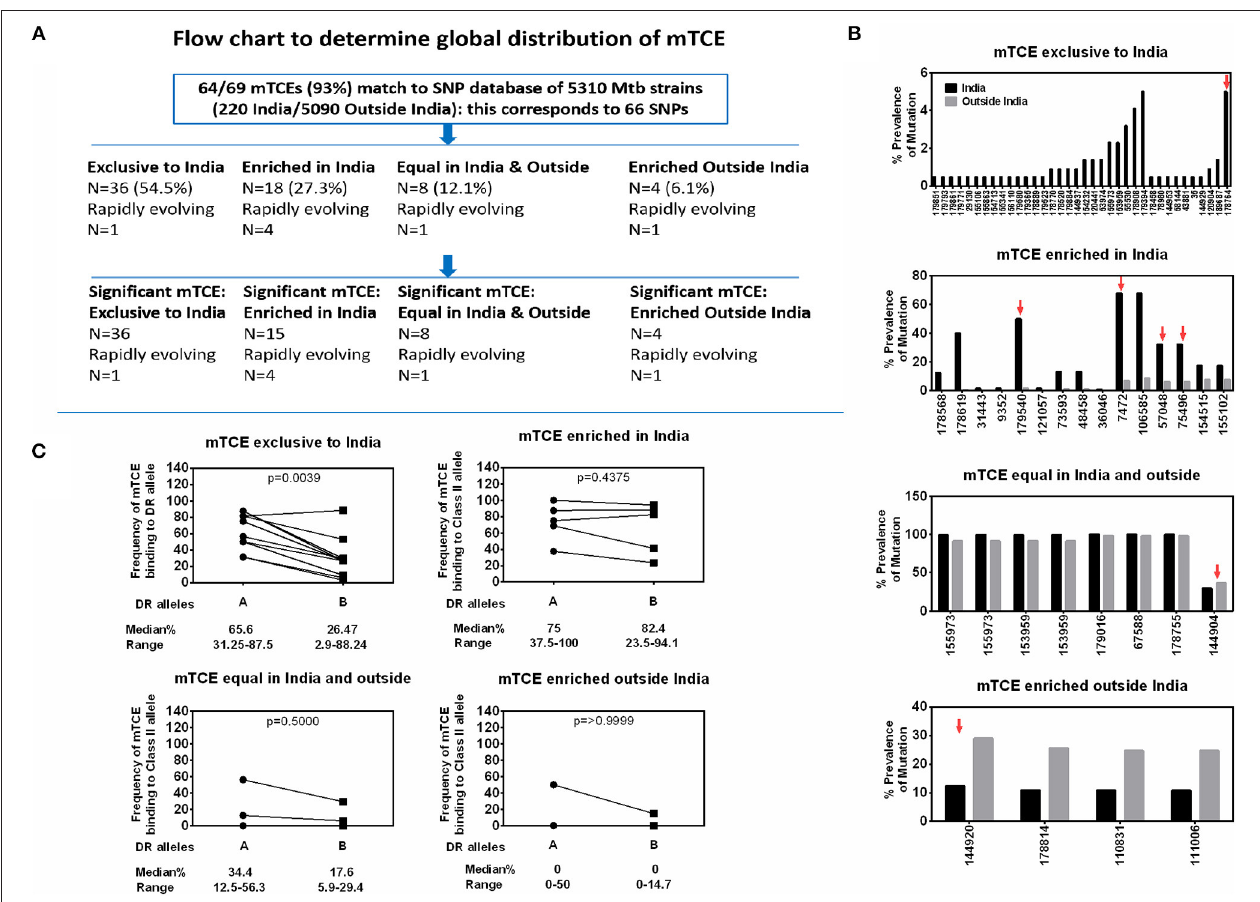
FIGURE 6 | Global distribution of 64 mTCEs and relationship to HLA-DR binding. (A) Flow chart shows the number of mTCEs identified in 79 Mtb strains from India, and their frequency in the context of non-synonymous SNPs (nSNPs) identified in 5,310 globally distributed Mtb strains ( 18, 60). After excluding mTCEs from repetitive regions ( n = 69/138), the remaining 69/138 mTCEs were mapped to nSNPs of 5,310 global Mtb strains, in which 64/69 mTCEs matched to corresponding 66 SNPs (some mTCEs have more than one mutation with each mutation corresponding to one SNP). These 66 SNPs in 64 mTCEs were classified into four groups based on their global geographic distribution in 5,310 Mtb strains as follows: mTCE exclusive to India; mTCE enriched in India; mTCE in equal proportion inside and outside India and mTCE enriched outside India. Of the 4 groups of mTCE identified, those that were significantly exclusive to ( N = 36) enriched ( N = 15) or enriched outside India ( N = 4) as determined by Fischer’s exact test adjusted for multiple comparison with a p -value cut-off of < 0.001 is shown. Only for one group: mTCE in equal proportion in both India and outside India ( N = 8) all the mTCEs identified is shown irrespective of significance. (B) Each bar is an mTCE (IEDB Epitope ID of corresponding reference epitope) (X-axis list) that corresponds to the proportion of prevalence of mutation (Y Axis list) in India (black square) vs. outside India (gray square). Red arrow above the bar represents rapidly evolving epitopes. (C) Paired line graph show the frequency (percentage) of all 15-mer mTCE from each of the 4 groups listed in Figure 6B binding with high affinity ( < 10nM) either to 16 HLA-DR alleles that are common in India (but also prevalent outside India) vs. a total of 34 HLA-DR alleles that are either not common in India or not reported in India. P -value determined by Wilcoxon matched-pairs signed rank t